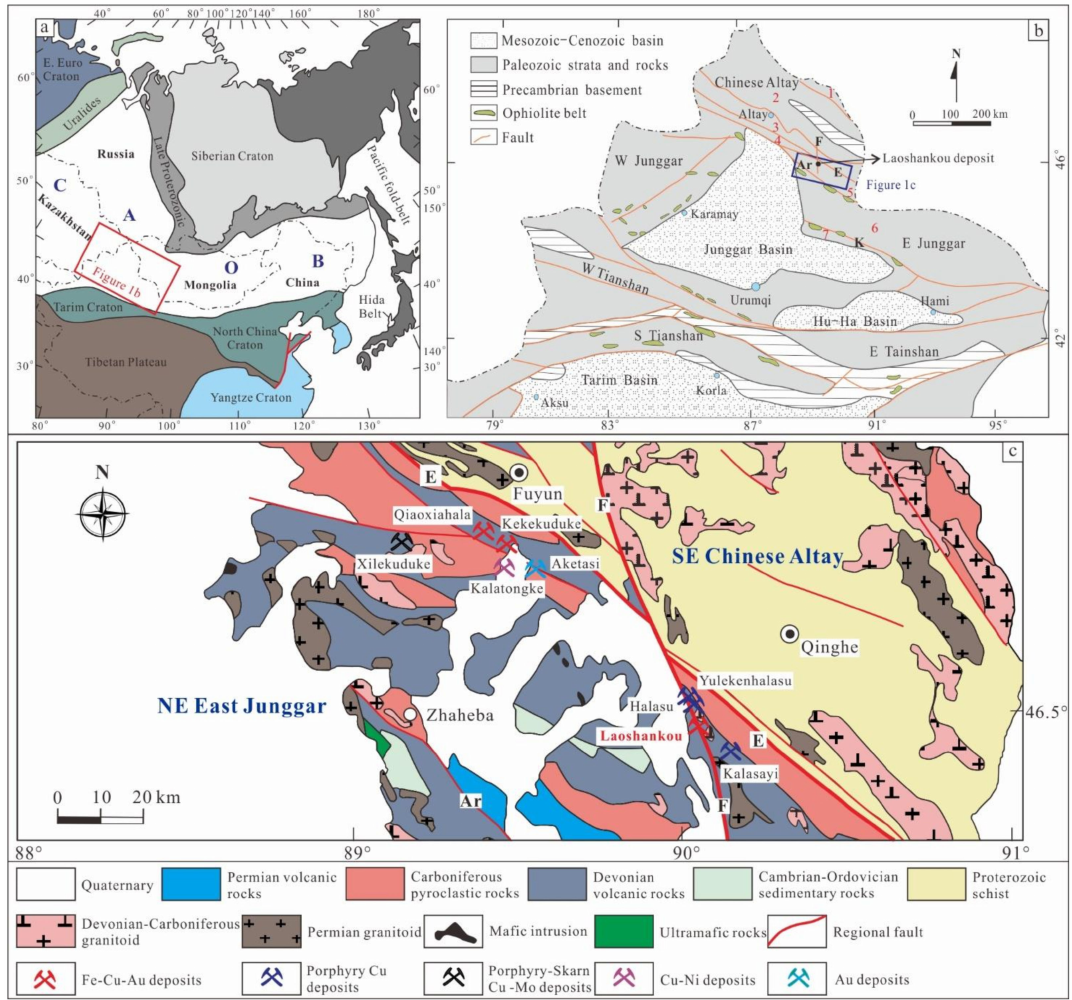
Figure 1. ( a ) Simplified tectonic map of the Central Asian Orogenic Belt (CAOB) (modified from [23]). ( b ) Simplified geologic map of North Xinjiang (modified from [24]). ( c ) Regional geologic and mineralization map of the SE Chinese Altay and NE East Junggar (modified from [26,27]). Abbreviations (fault): Ar, Armantai; E, Erqis; F, Fuyun; and K, Kelameili. Abbreviations (geological terrane): 1, Norte; 2, Central Altay; 3, Qiongkuer-Abagong; 4, Erqis; 5, Dulate; 6, Yemaquan; and 7,